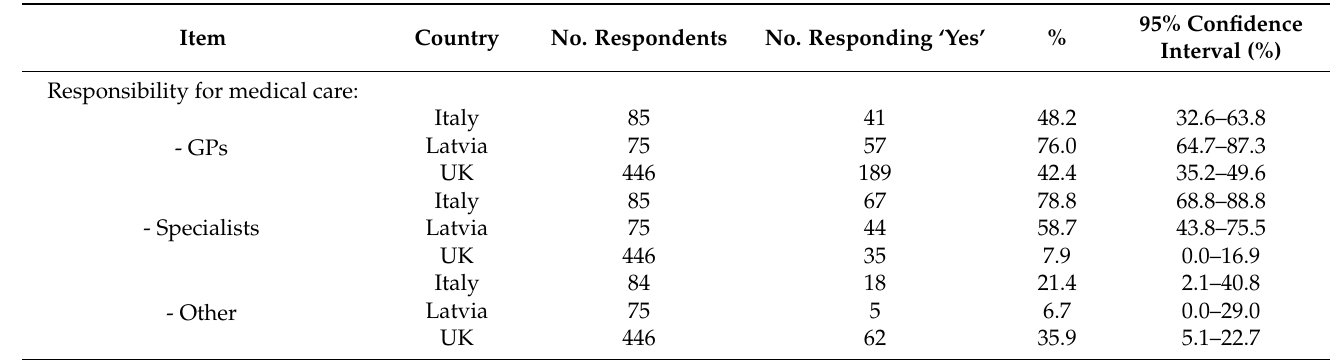
Table 5. Responsibility for medical care.